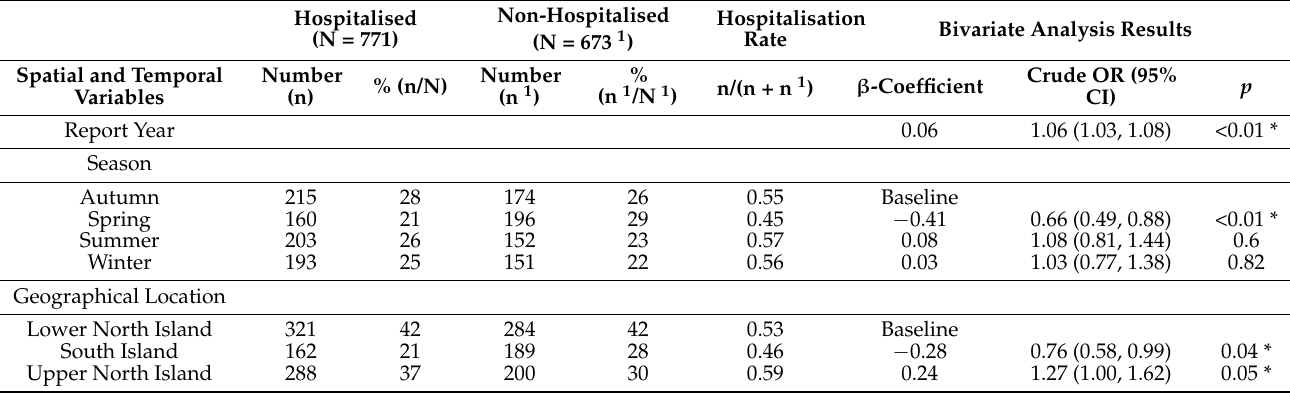
Table 3. Spatial and crude odds ratios for hospitalisation amongst notified cases of leptospirosis in New Zealand